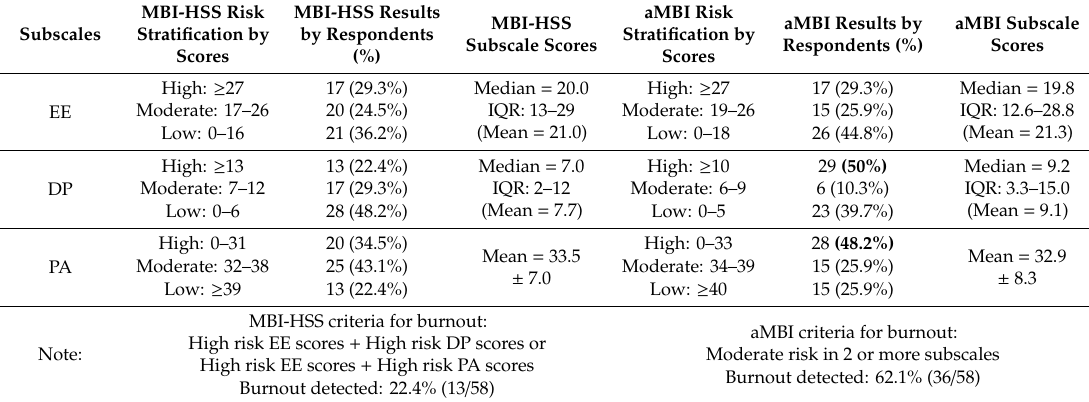
Table 2. Comparisons of subscale cut-o ff values and burnout symptoms in the MBI-HSS and the aMBI. Parametric data reported as mean ± standard deviation (SD); non-parametric data as median and interquartile range